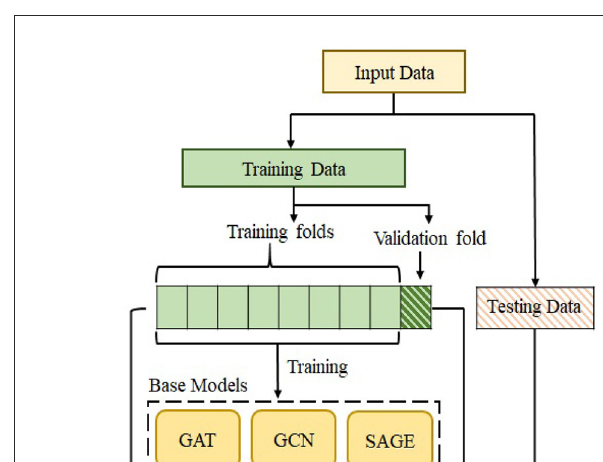
FIGURE4 Flowchart to show the process of ensemble model.